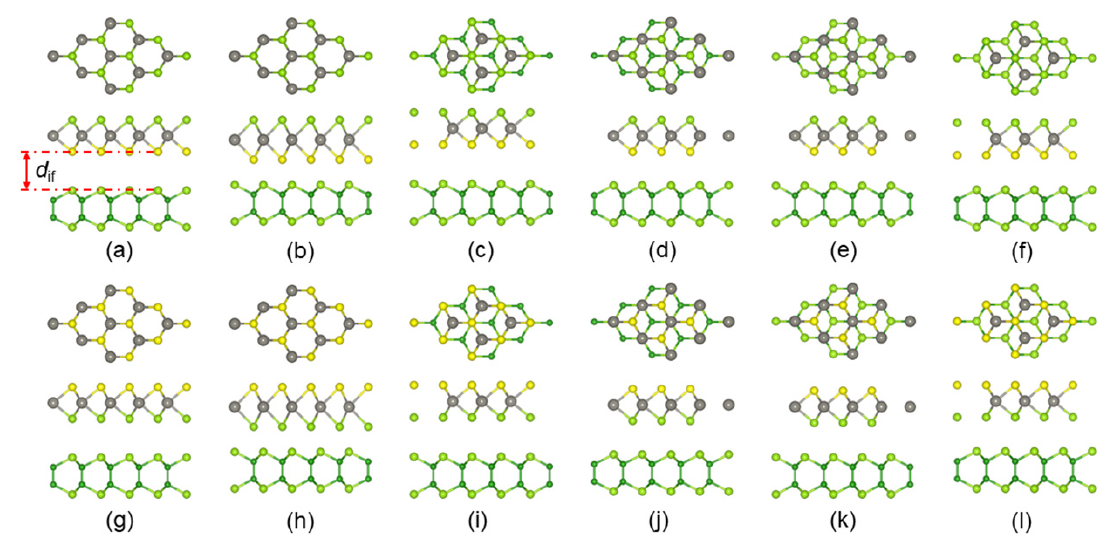
Figure 2. The different stacking patterns of WSSe/BSe heterostructure: ( a ) γ -1; ( b ) γ -2; ( c ) γ -3; ( d ) γ -4; ( e ) γ -5; ( f ) γ -6; ( g ) γ -7; ( h ) γ -8; ( i ) γ -9; ( j ) γ -10; ( k ) γ -11; ( l ) γ -12.